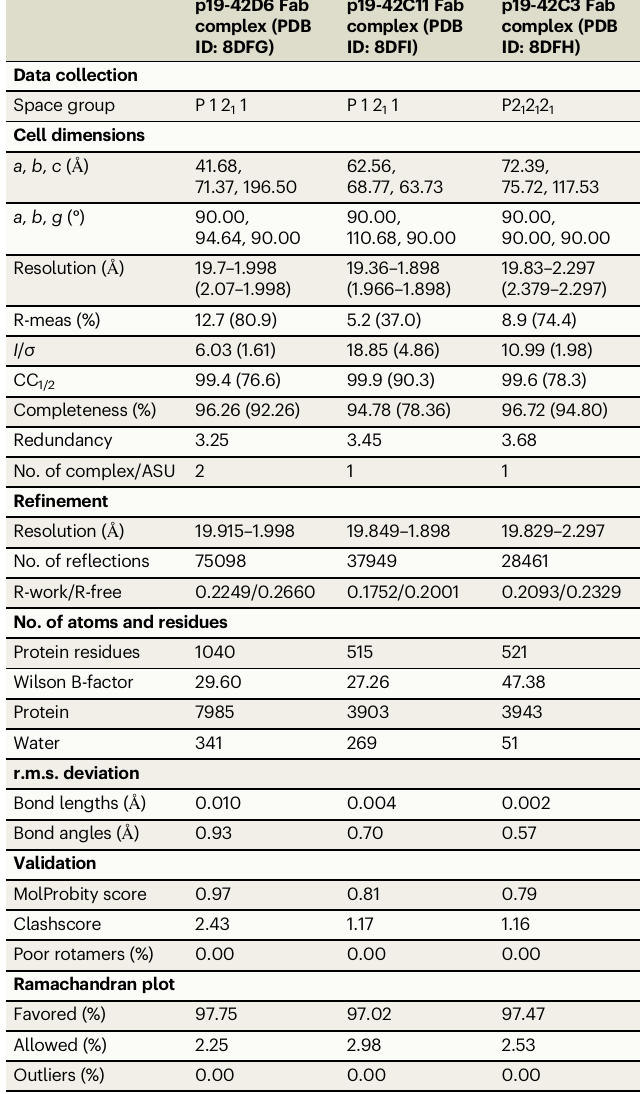
Table 2 | Crystallography data and re fi nement statistics p19-42D6 Fab complex